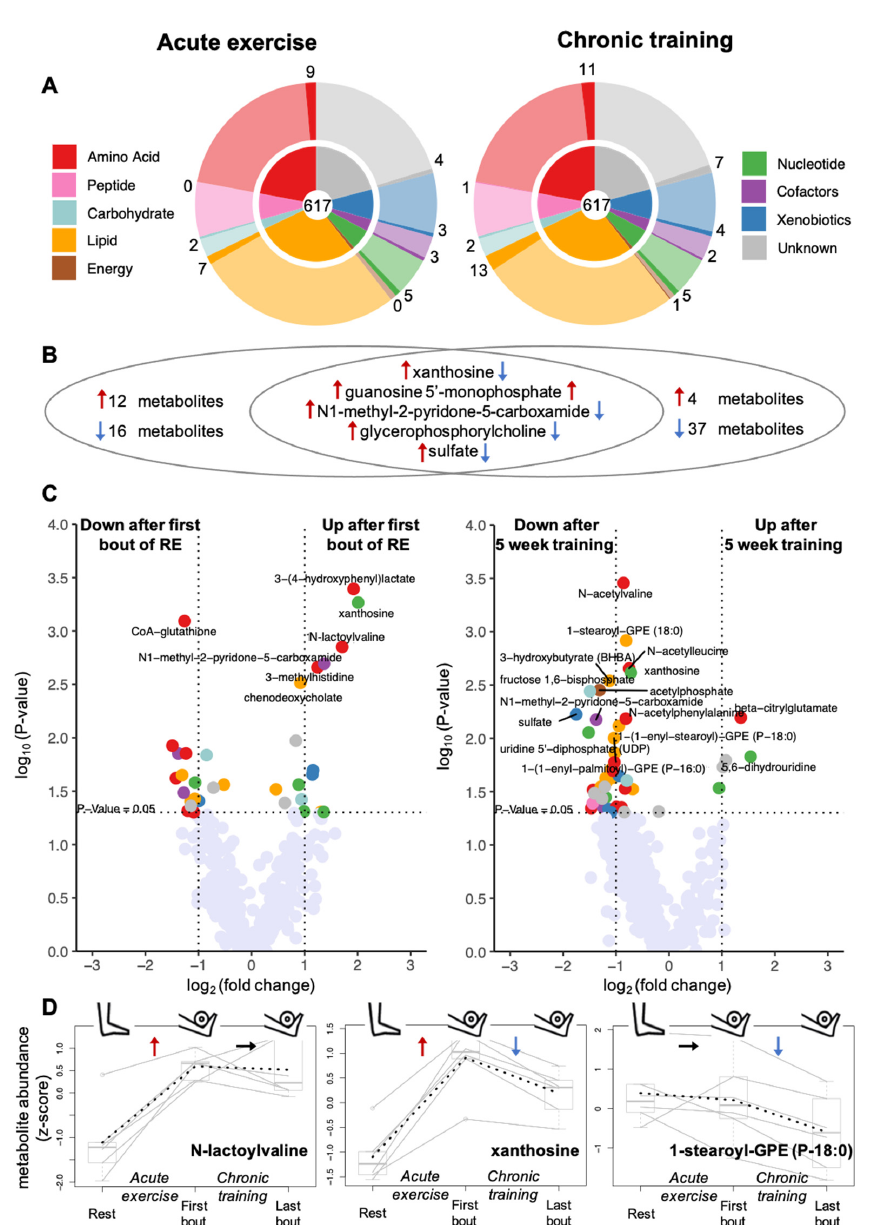
Figure 3. Effects of acute exercise and chronic training on muscle metabolome. ( A ) The 617 analysed metabolites belong to nine different metabolite classes; the inner circles of the pie charts show the fraction of metabolites falling into each class; the fraction of affected metabolites ( p < 0.05) per class is marked by saturated colour in the outer rings. ( B ) In total, acute exercise (i.e., comparing metabolite levels after first bout of exercise with levels at rest) and chronic training (i.e., comparing levels after last bout of exercise after 5 weeks training with levels after first bout of exercise) showed an effect on 33 (left) and 46 (right) metabolites, respectively, with 5 metabolites being changed in response to both conditions (middle); red arrows indicate an increase, blue arrows a decrease in metabolite levels. ( C ) Volcano plots displaying the p -values ( − log10) versus log2 fold changes of all metabolites after acute exercise (left) and after chronic training (right); metabolites with p < 0.05 are shown in the color of their metabolite class using the same color coding as in A. ( D ) Metabolite levels for all 6 participants at the three sampling points shown for three selected metabolites with typical patterns of changes after acute exercise (N-lactoylvaline; left), chronic training (1-stearoyl-GPE (P-18:0); right), and both conditions (xanthosine; middle), respectively; solid lines connect the levels of each individual; dotted lines connect the mean levels at each sampling time